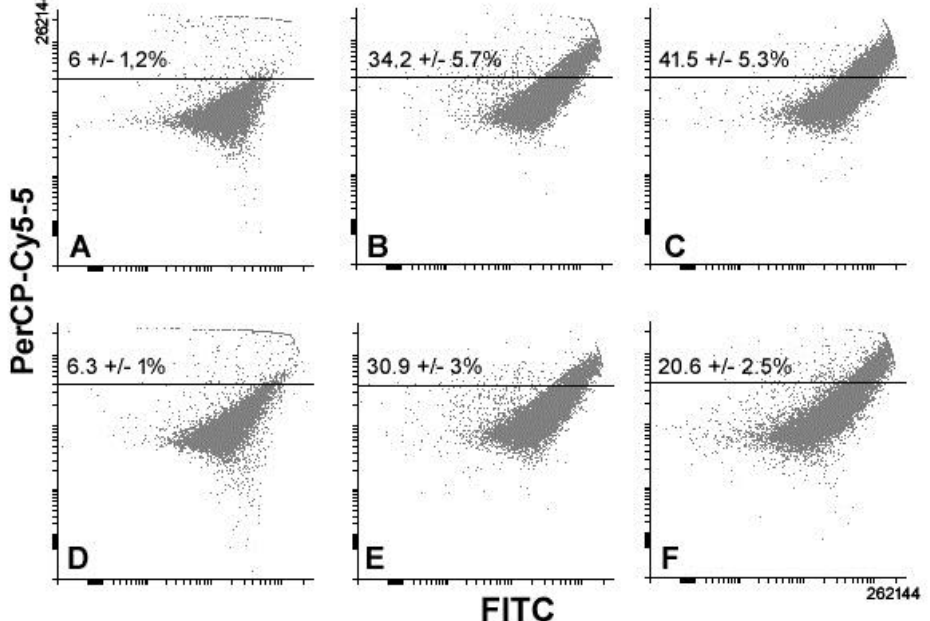
Figure 7. Representative flow cytometric analyses of control ( A , D ), total extract- ( B , E ), and 10K fraction-treated ( C , F ) MDA-MB231 cells stained with acridine orange for evaluation of acidic vesicular organelle (AVO) accumulation after 24 ( A – C ) and 48 h ( D , F ) of exposure. The percentage indicated in the top quadrants refers to the high red fluorescence-emitting events. The results are expressed as mean ± s.e.m. of triplicate assays.